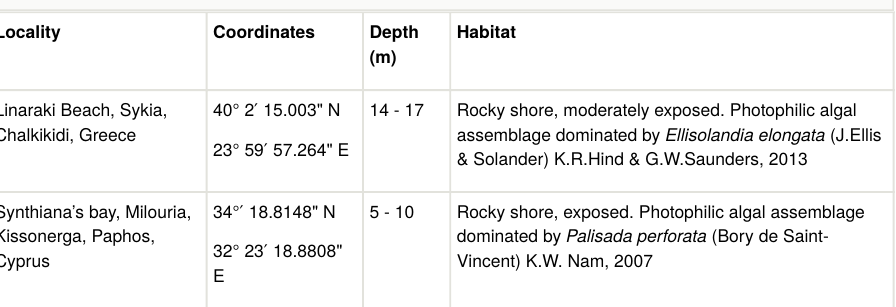
Locality, geographical coordinates, depth (m) and physical characteristics of the sampling